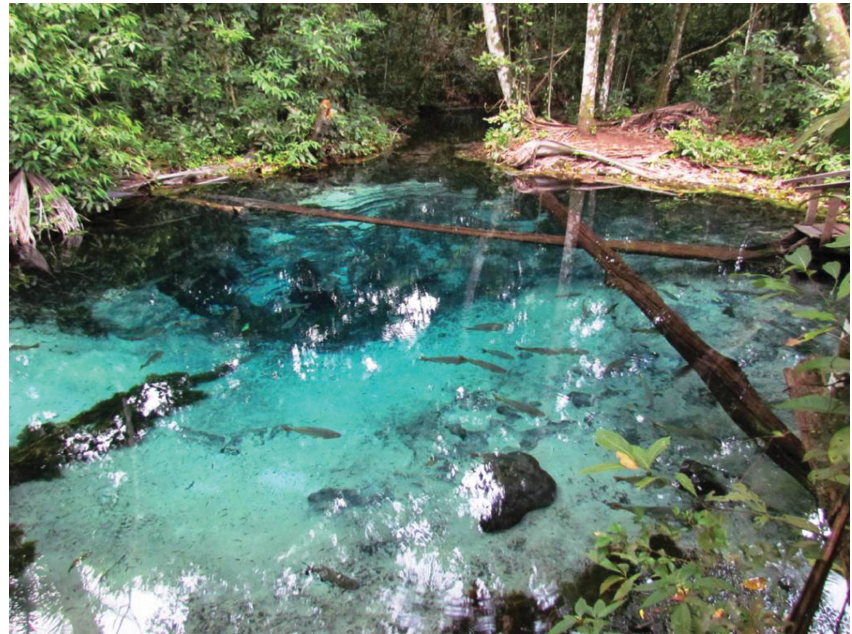
FIGURE 6 | Type locality of Astyanax nobre , rio Salobra at Lago Azul, tributary of rio Cuiabá, rio Paraguai basin, 14º35’43.2”S 55º58’09.6”W, Nobres, Mato Grosso State, Brazil. Photo by M. A.